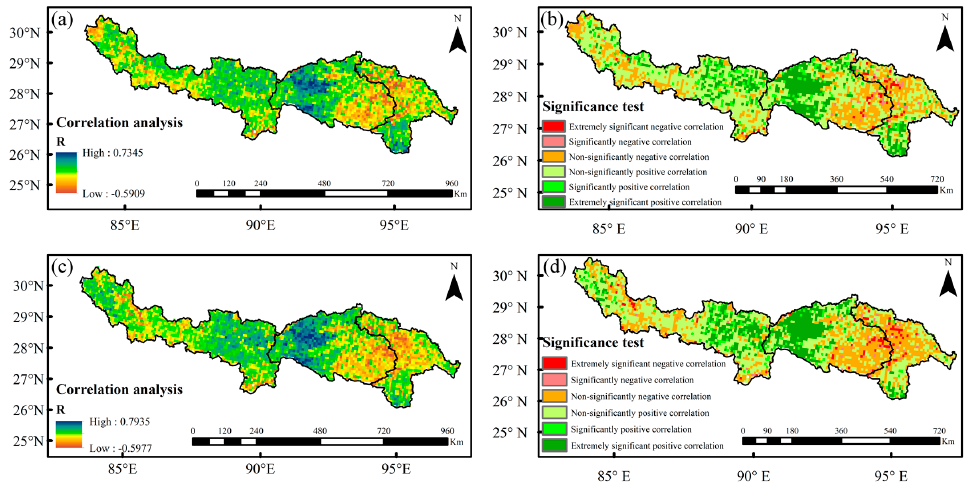
Figure 12. Annual ( a , b ) and growing season ( c , d ) correlation analysis between the SPEI and NDVI with the significance test. Table 7. Area ratios of NDVI and SPEI in different correlation degrees.